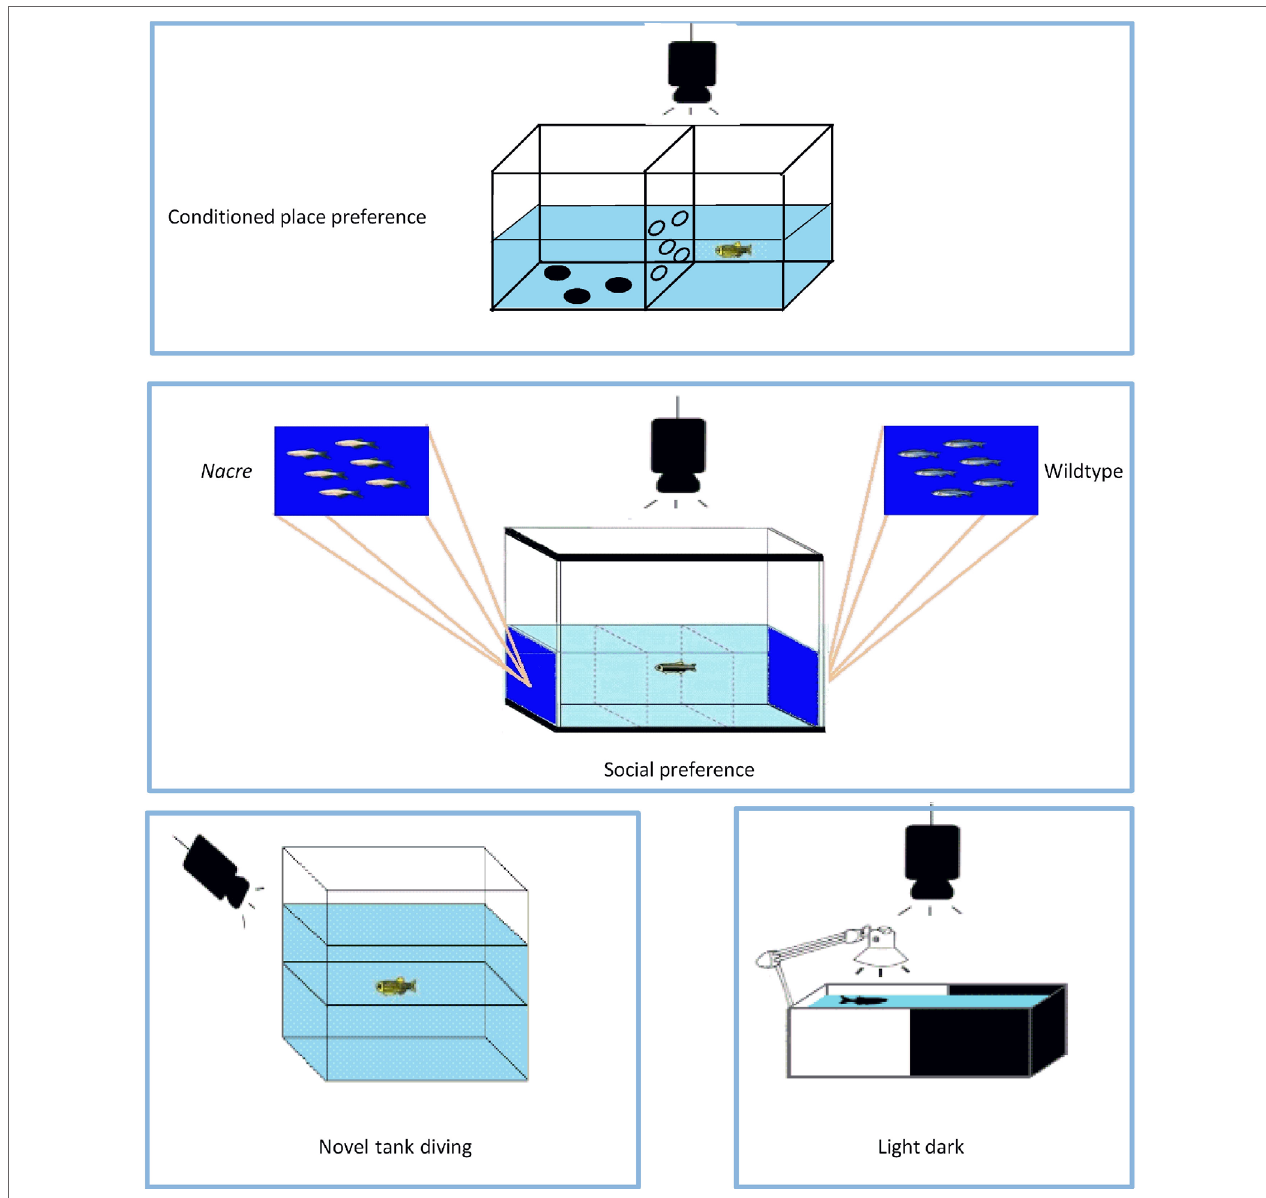
FigUre 2 | The apparatuses used in the study. The conditioned place preference test apparatus was used to evaluate the rewarding effects of 3,4-methylenedioxymethamphetamine (MDMA), 2,5-dimethoxy-4-bromo-amphetamine hydrobromide (DOB), and para -methoxyamphetamine (PMA). The social preference test apparatus was used to evaluate shoaling behavior. Anxiety-like behavior was studied using the novel tank diving and light–dark tests. For further explanation, see Material and